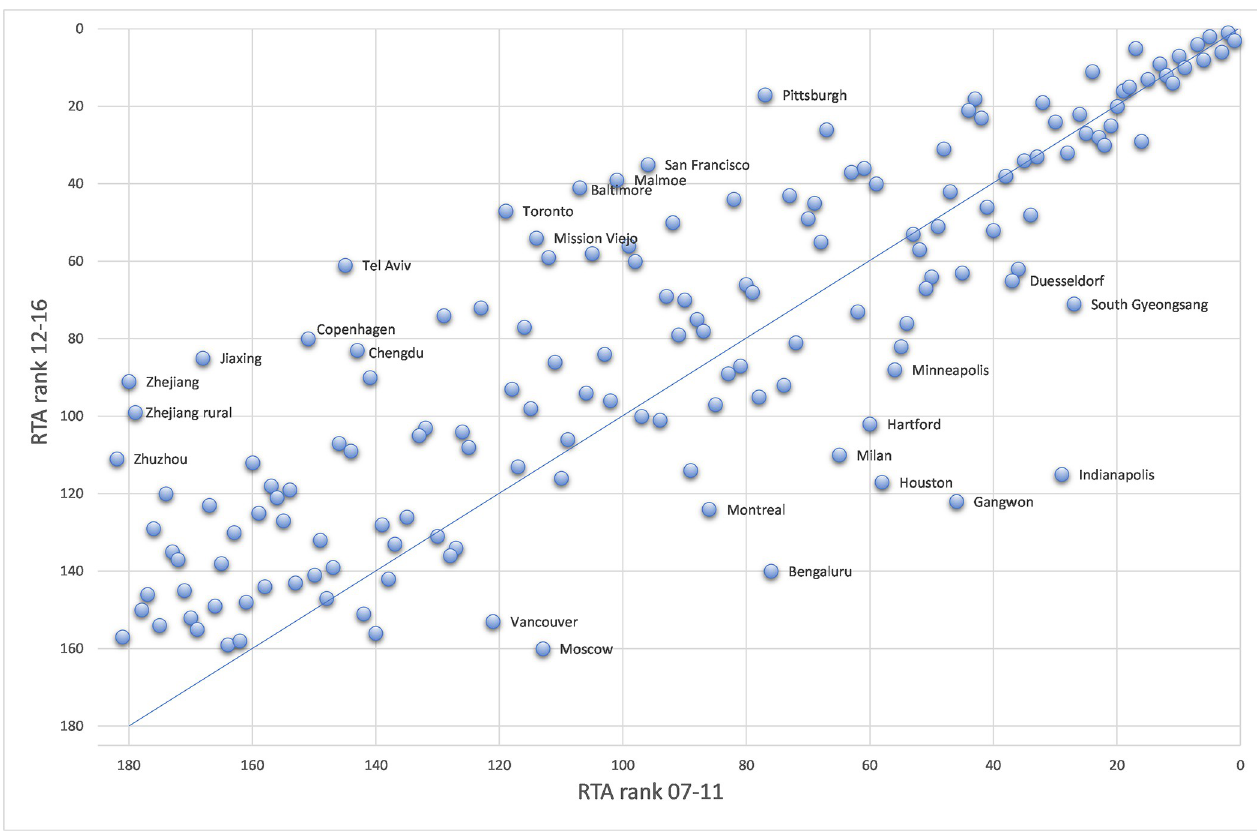
Fig 1. Dynamics of RTA